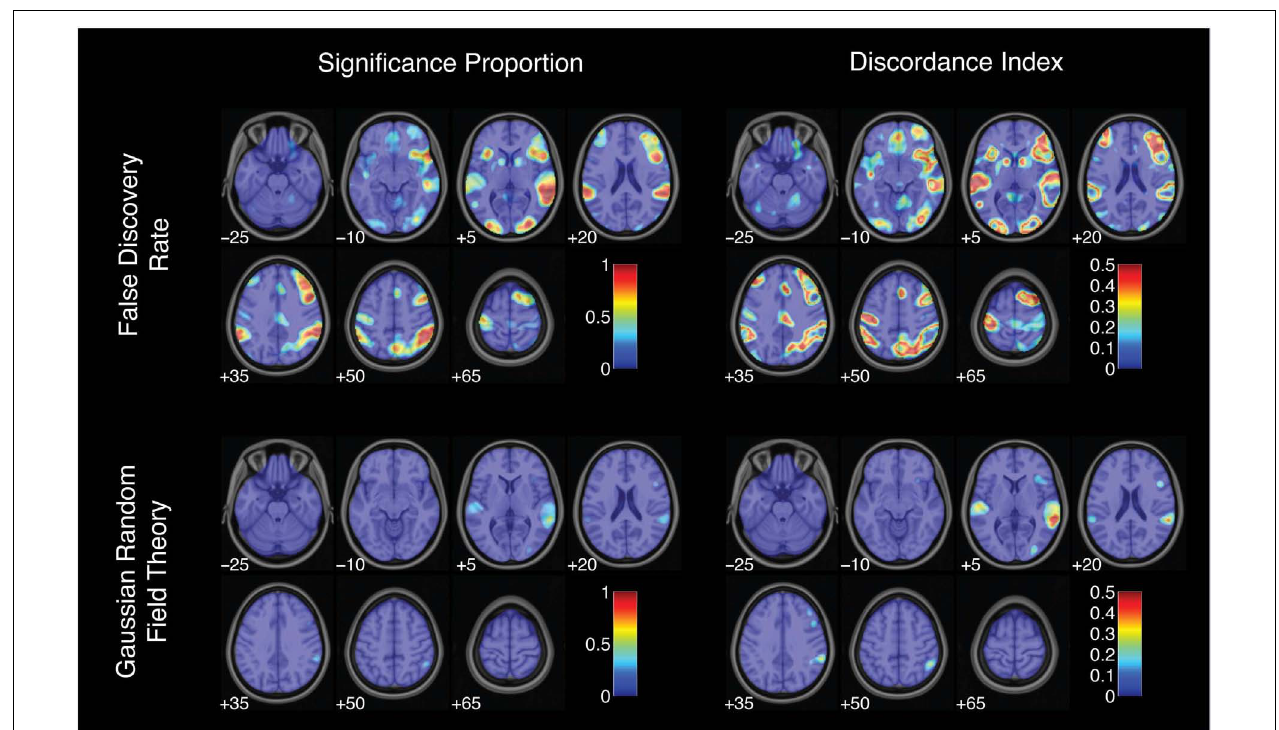
disagreement across threshold maps. Images are presented in neurological orientation, with the left hemisphere displayed on the left. Note that color scales range from 0 to 1 for significance proportion and from 0 to 0.5 for discordance